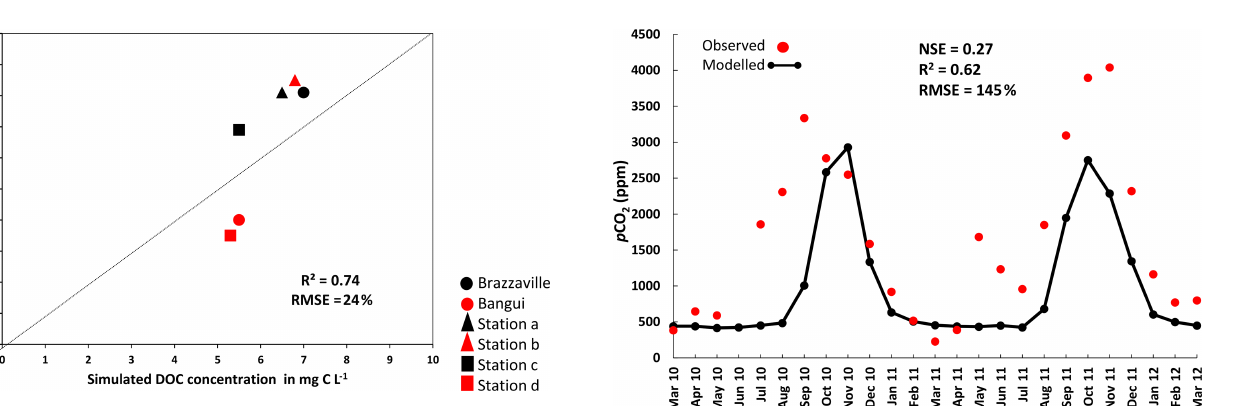
Figure 6. Time series of observed versus simulated p CO 2 at Ban- gui on the River Oubangui. Observed data are from Bouillon et al. (2012, 2014).